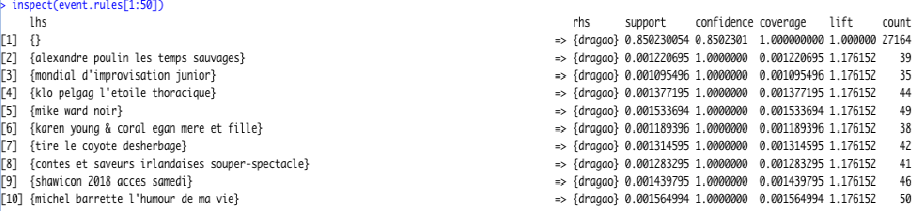
Fig. 3. General knowledge as Knowledge-as-a-Service.